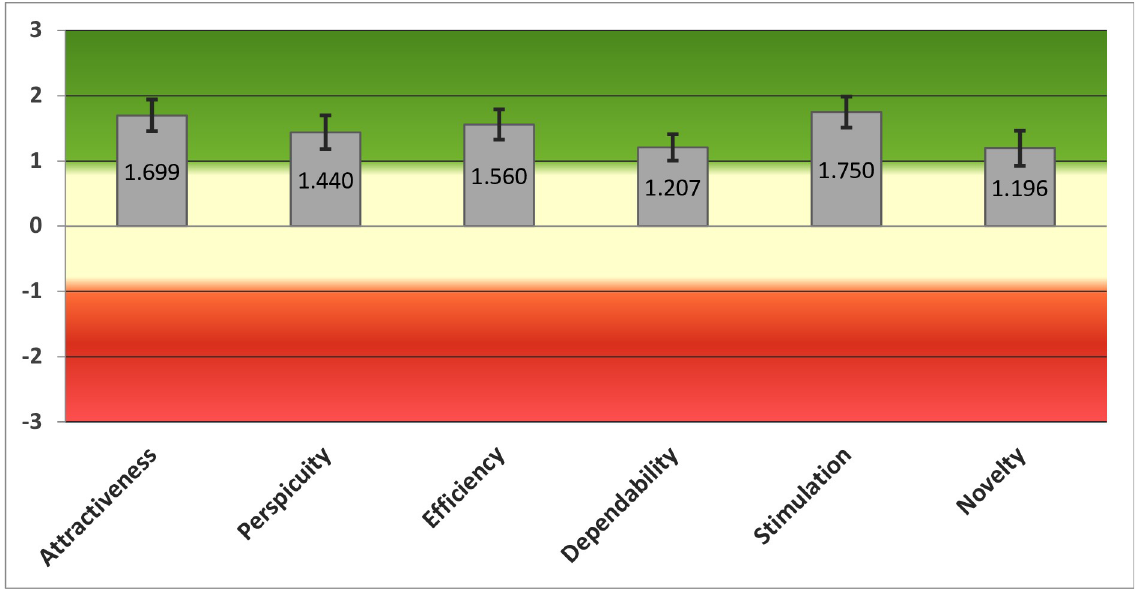
Fig 3. Mean scores of 6 composite domains with the output generated using the UEQ Data Analysis Tool 1 version 7.